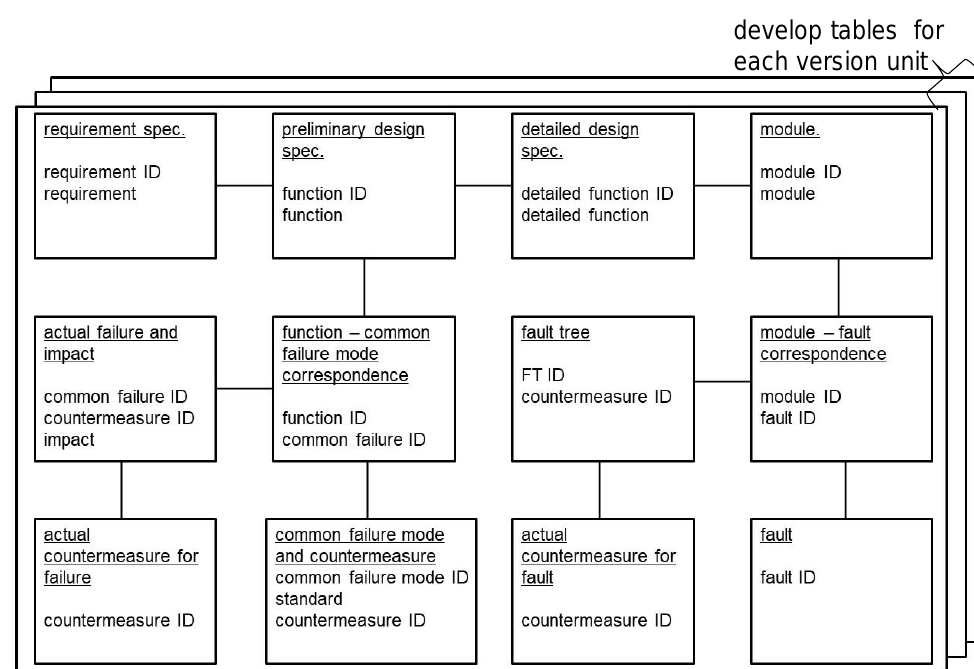
Figure 9. Outline of design and safety information database (DSDB) data structure.